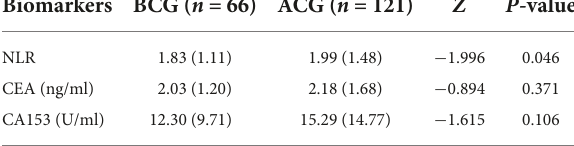
TABLE 2 Neuropsychological tests and memory performance in the before and after chemotherapy.